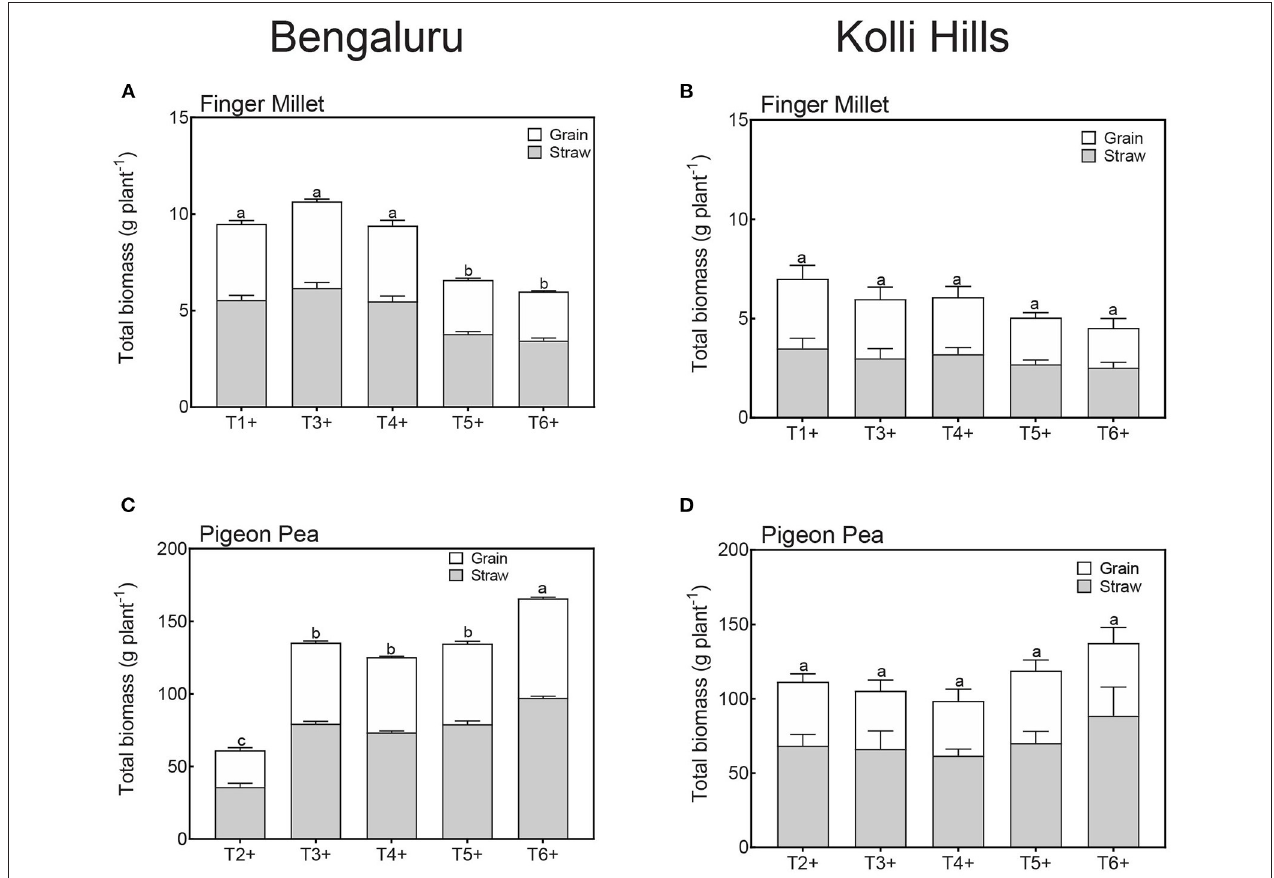
FIGURE 6 | Total biomass per plant of FM and PP at Bengaluru (A,C) and Kolli Hills (B,D) during 2016/17 field trial. Bars represent the average of four replicates with standard error of mean. One-way ANOVA followed by Tukey‘s test ( post-hoc test) was used for the combined biomass of grain and straw, separately for each site, and values with same letters are not significantly different from each other at p >